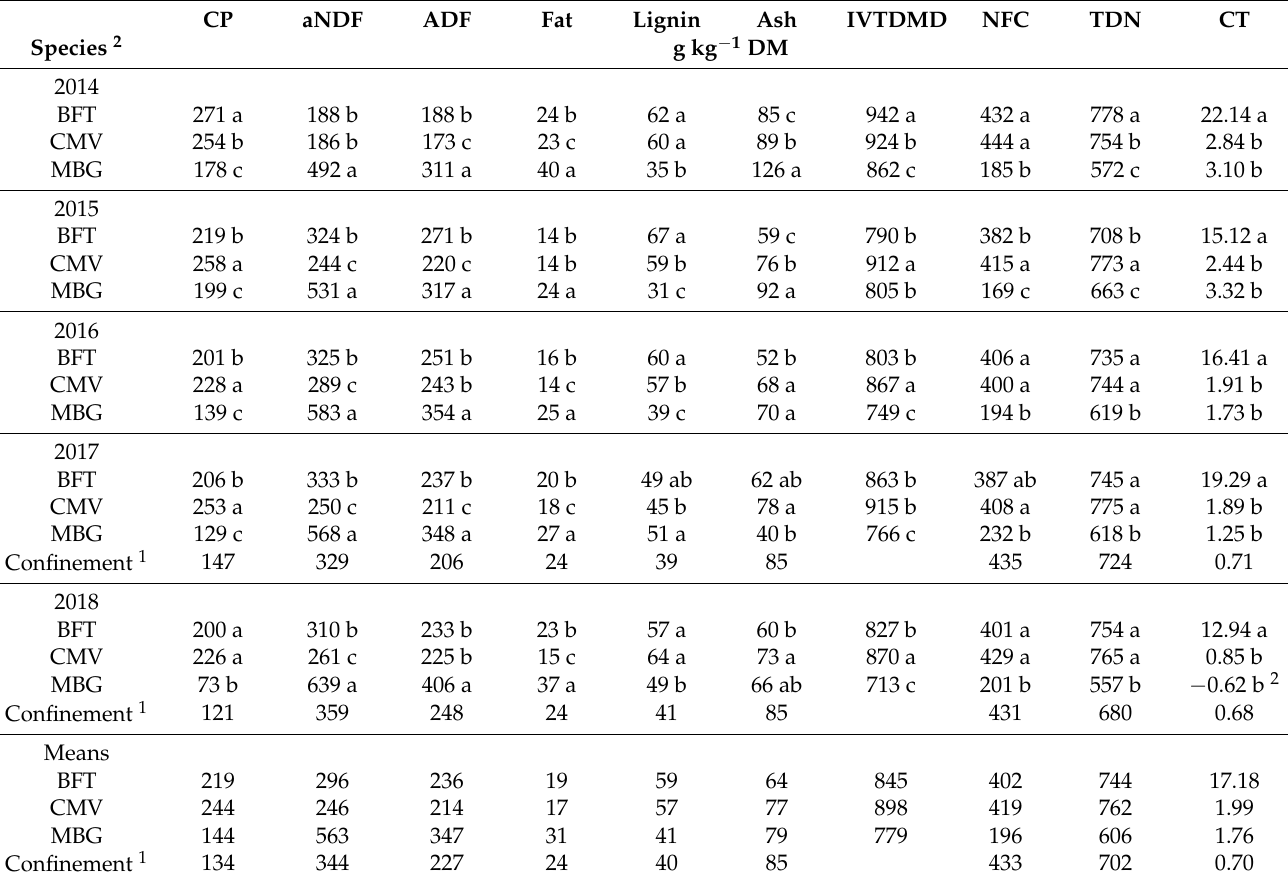
Table 2. Grazing period forage nutritive value characteristics determined using near infrared spec- troscopy